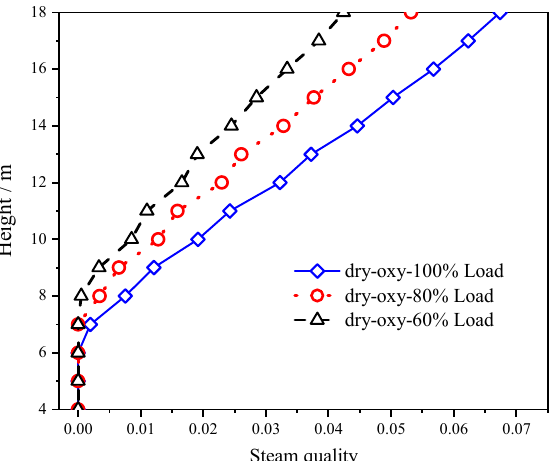
28% concentration of dry FGR oxy-fuel combustion.